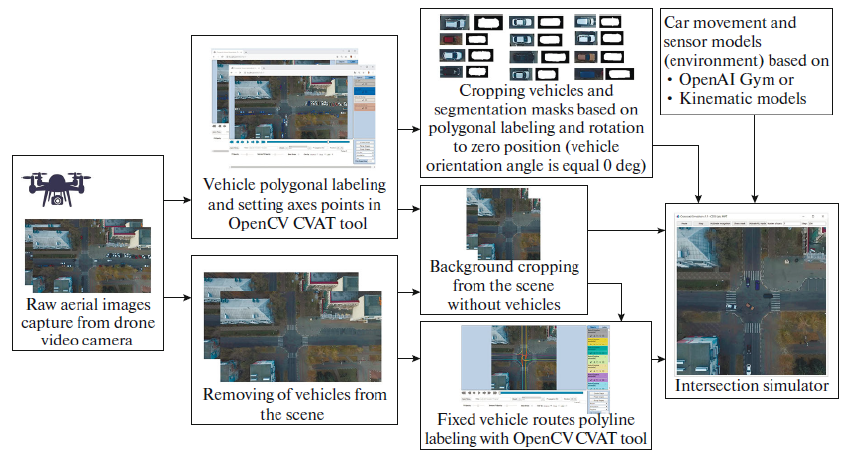
Figure 7. Flowchart of the RL: computer vision process for an intersection [33].